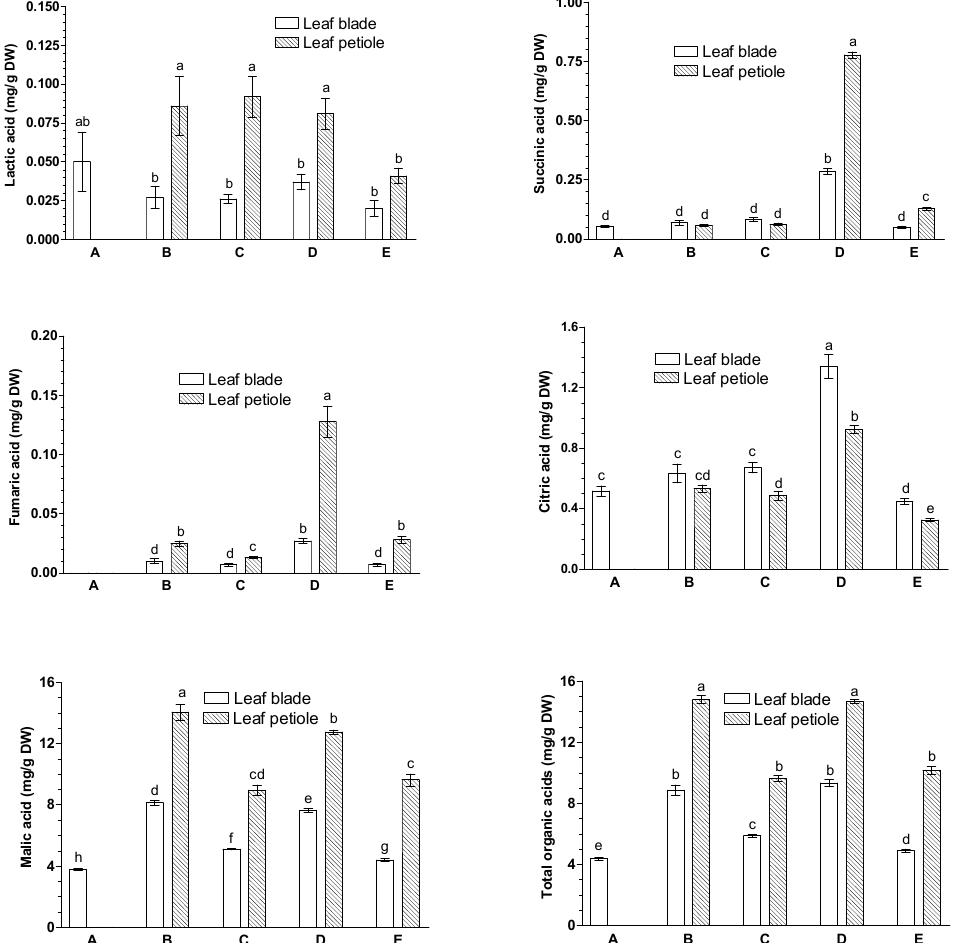
Figure 2. Effects of methyl jasmonate (JA-Me) applied to the adaxial and abaxial sides of the leaf blade on the contents (mg/g DW) of organic acids in leaf blades and petioles of G. biloba . Mean results ± SD followed by the same letter were not significantly different ( p < 0.05) according to Tukey’s test. A—initial stage, leaf samples collected on 9 September; B—control (lanoline), leaf samples collected on 30 September; C—JA-Me applied to the adaxial side, leaf samples collected on 30 September; D—JA-Me applied to the abaxial side, leaf samples collected on 30 September; E—naturally senesced leaf, samples collected on 20 October.